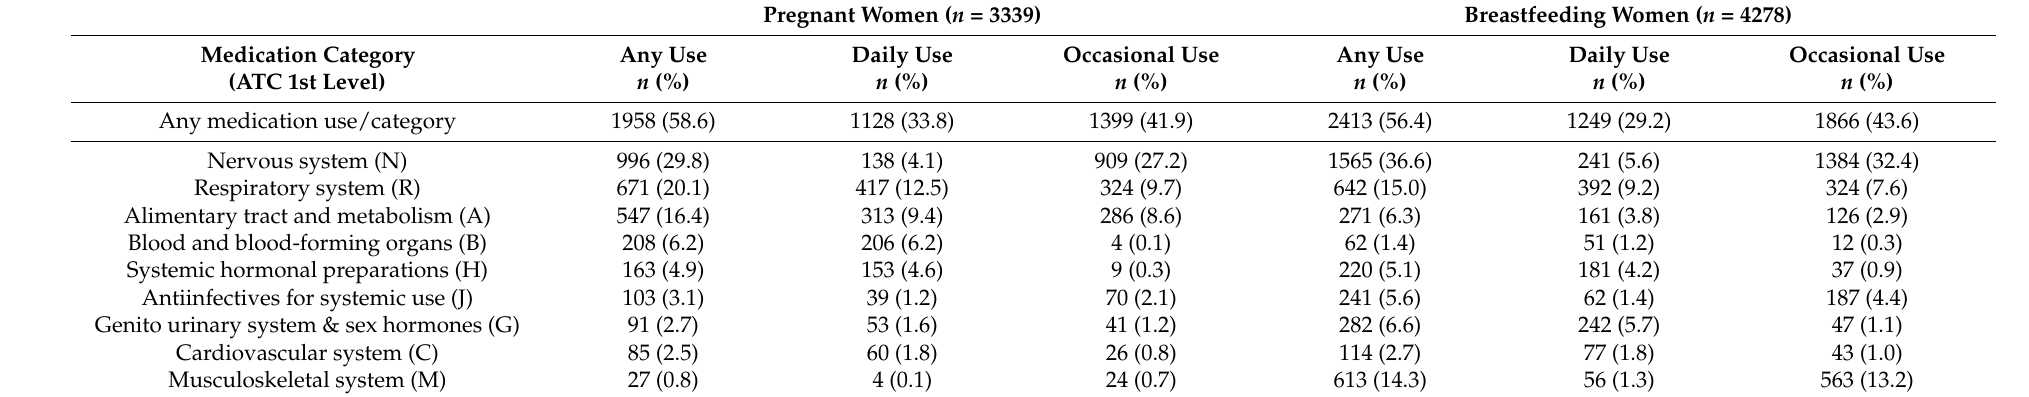
Table 2. Any, daily and occasional medication use on 1st ATC level among pregnant and breastfeeding